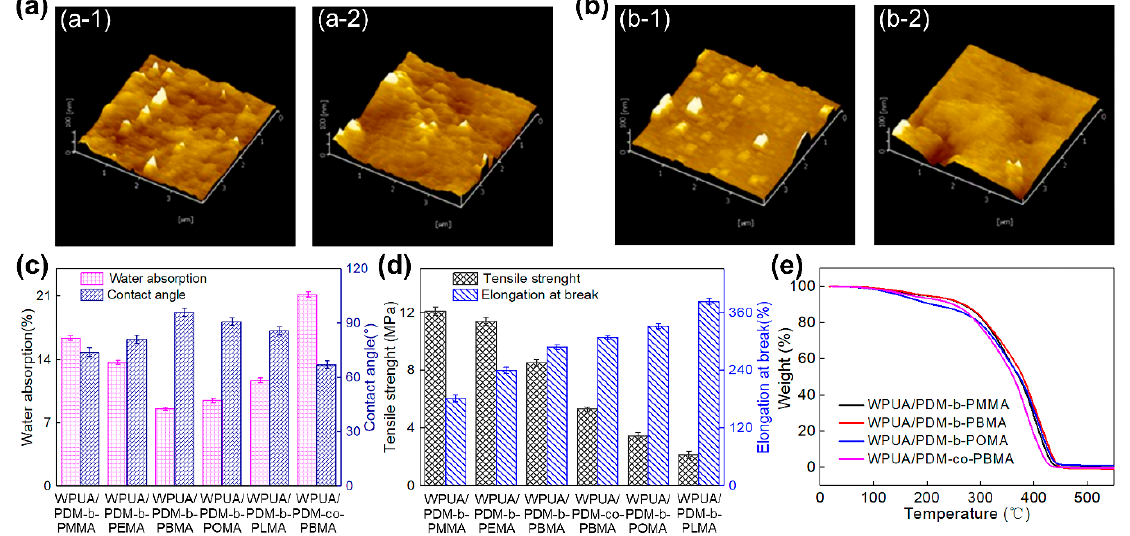
Figure 11. AFM images of WPUA/PDM- b -PBMA latex film immersed in water for 0 h ( a-1 ) and 24 h ( a-2 ), WPUA/PDM- co -PBMA latex films immersed in water for 0 h ( b-1 ) and 24 h ( b-2 ). Effect of PDM- b -PRMA and PDM- co -PBMA on the water absorption ( c ), mechanical properties ( d ) and thermal stability ( e ) of WPUA/PDM- b -PRMA and WPUA/PDM- co -PBMA latex film.